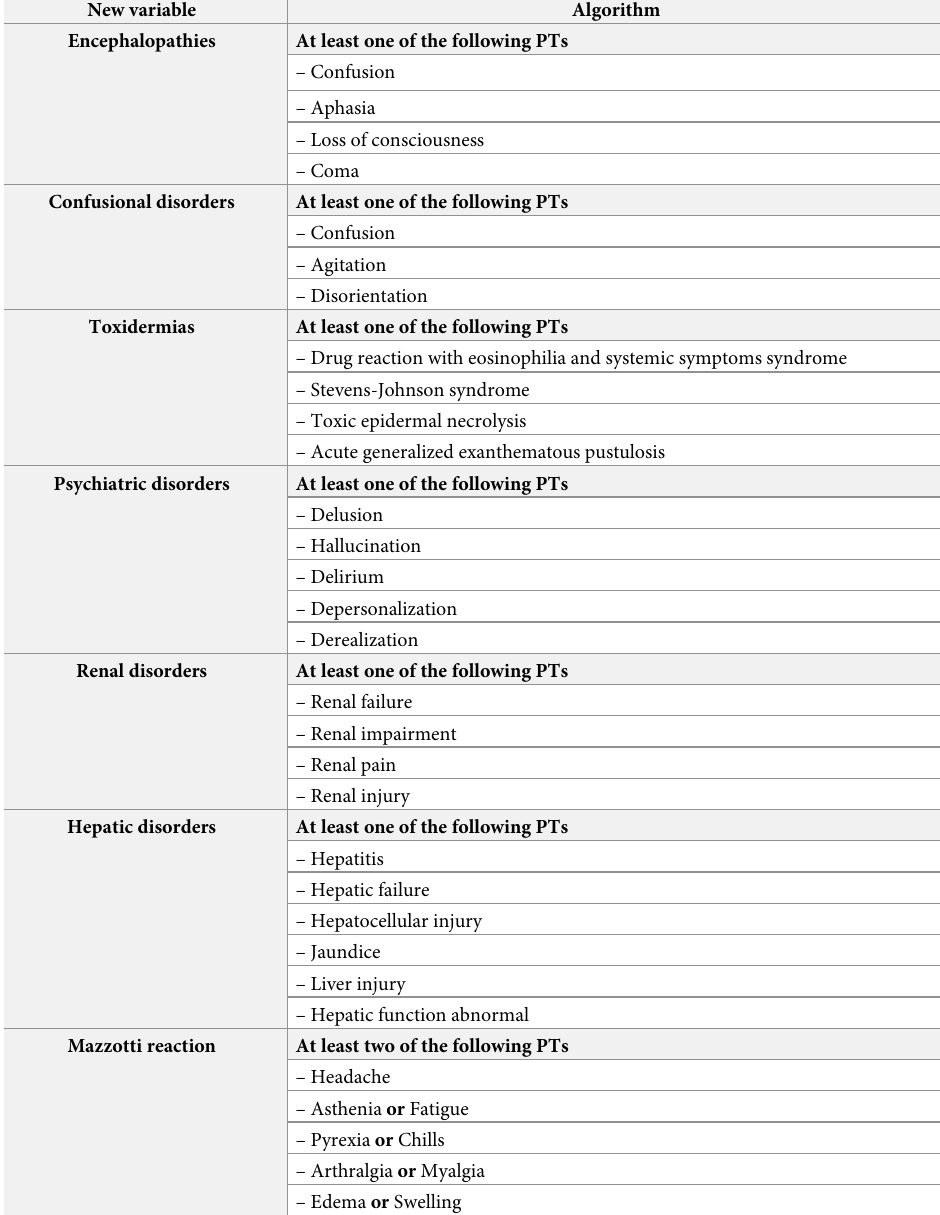
Table 1. Mapping of the PTs for the most common symptoms of syndrome of interest to a new